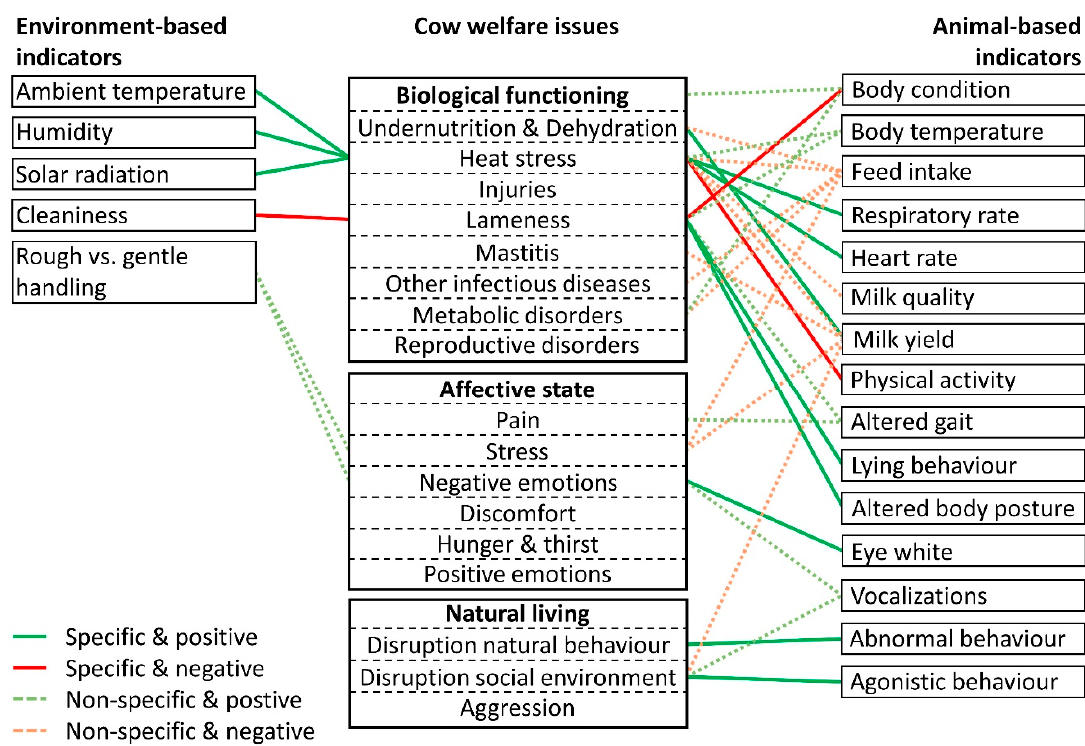
Figure 1. Indicators that have a significant (binomial test, p < 0.05) direction of association with single cow welfare issues (middle). Indicators are categorized as either environment-based (left) or animal-based (right). The welfare issues are categorized according to the welfare concern they relate primarily too. If the indicator has no similar association (in terms of direction) with other welfare issues, the association is indicated by a straight line (specific). If a similar association occurs also with another welfare issue, the association is indicated by a dotted line (non-specific). Positive associations are indicated by green lines and negative associations by red lines.